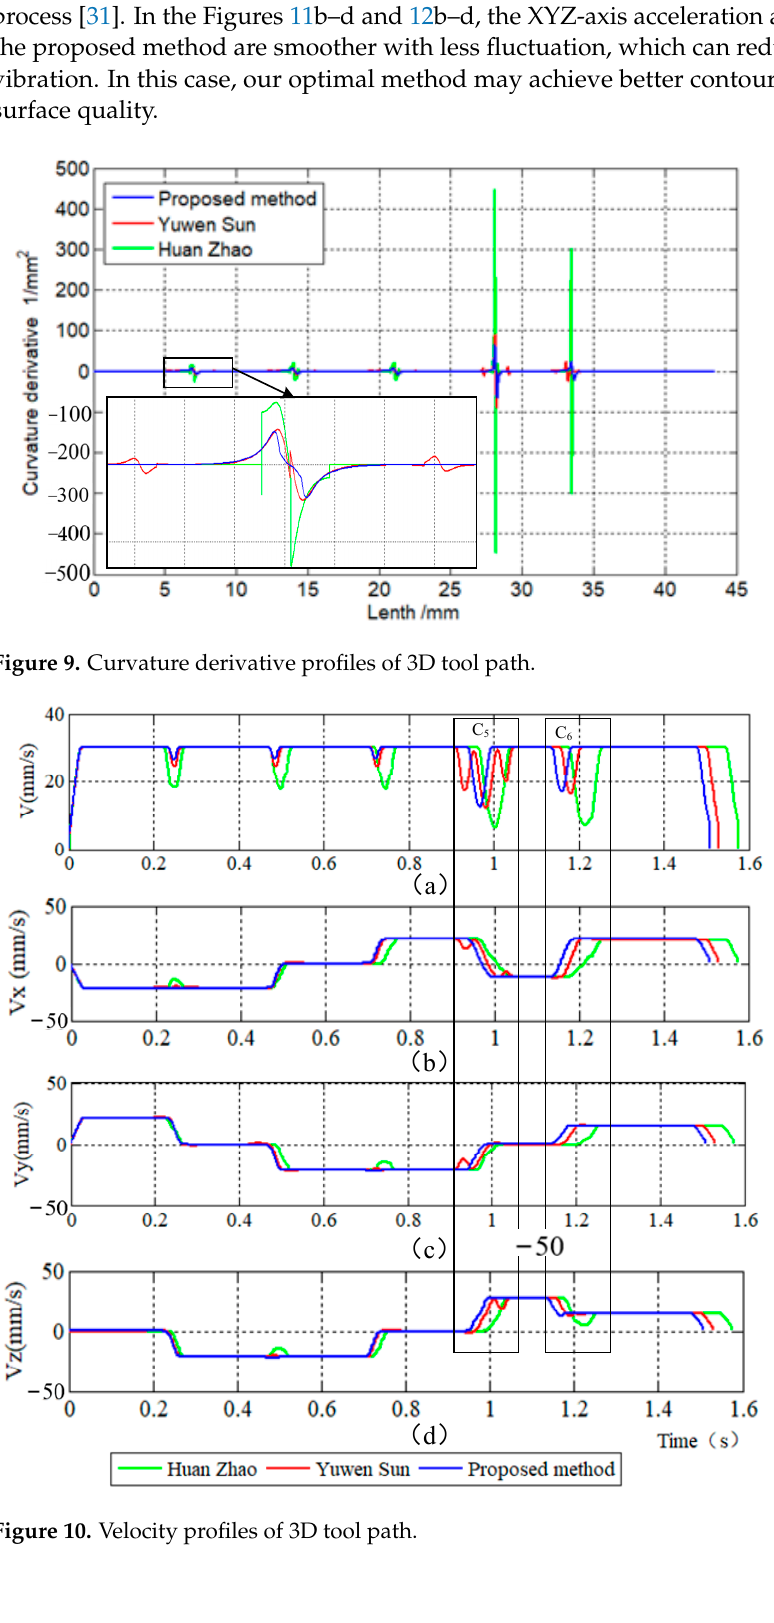
Figure 10. Velocity profiles of 3D tool path.